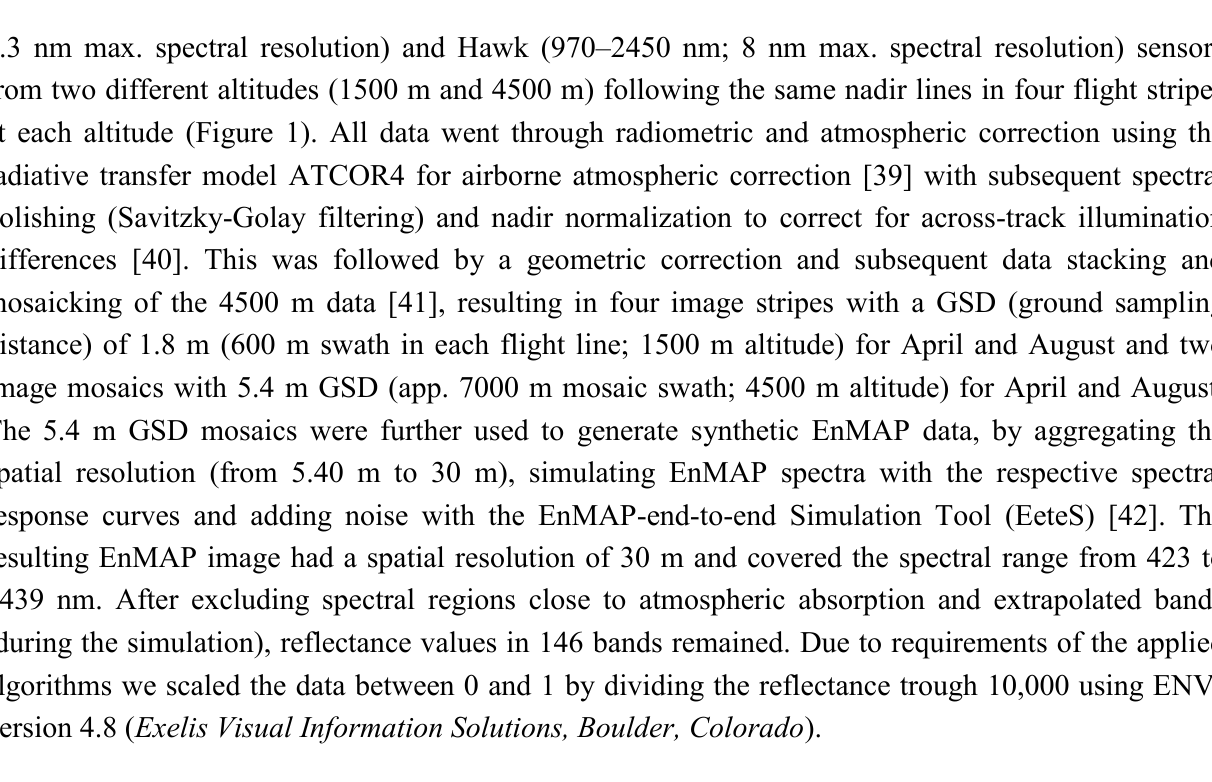
Figure 2. Exemplary spectral signatures of 30 × 30 m simulated EnMAP shrub pixel with below 10% ( red ), approximately 50% ( green ) and above 90% shrub fraction ( black